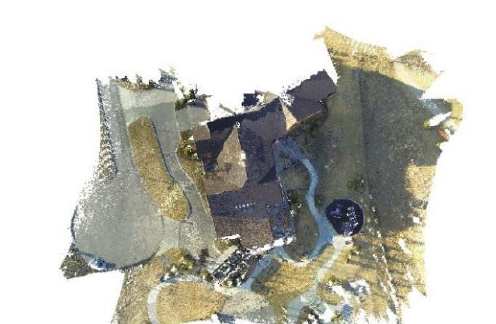
Figure 5. Result from the UAV-image dataset: (a) original left image, (b) original right image, (c) normalized left image, (d) normalized right image, (e) disparity image derived from the implemented semi-global dense matching, and (d) refined disparity image by applying the proposed approach, the improved area is highlighted with the red circle.